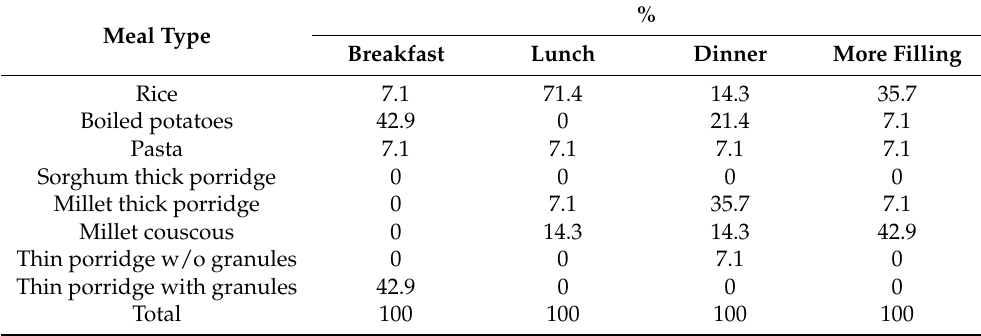
Table 2. Frequency (%) of preference of the different test meals, and comment on fullness ( n = 14).